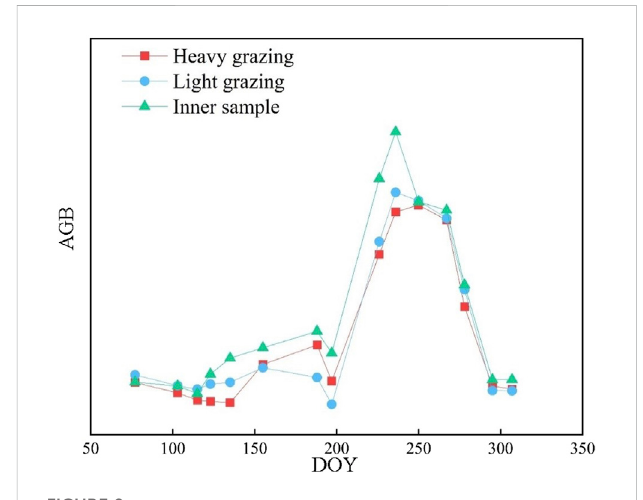
FIGURE 9 Time series changes (day of year, DOY) of the above ground biomass (ABG) vegetation index on different